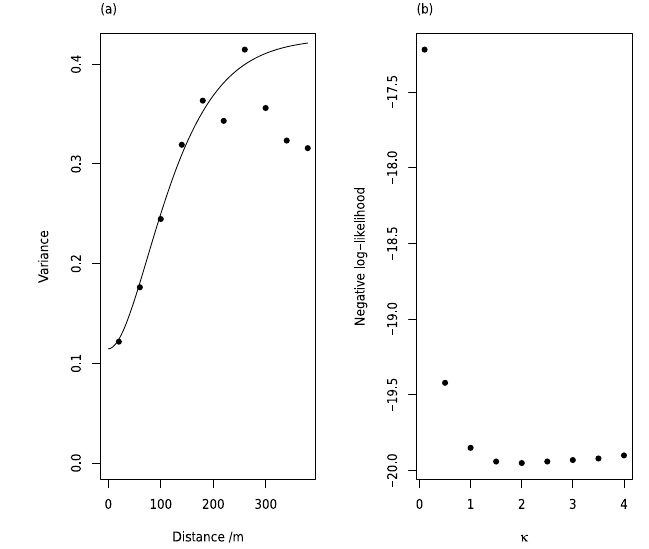
Figure 2. (a) Method-of-moments estimates of the variogram of soil uranium content with the maximum likelihood estimate of the variogram superimposed. (b) Profile values of the negative log like- lihood for different values of the κ